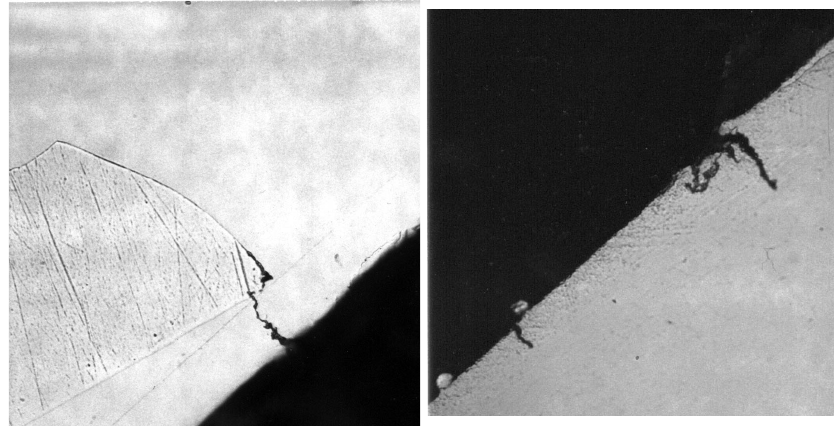
FIG. 17. An internal cross section of one end cap in the region of maximum temperature rise on the surface. The end cap surface is the boundary between the white and black regions of the pictures. The crack on the left propagated 25 (cid:3) m into the surface before reaching an internal grain boundary. The crack on the right propagated 15 (cid:3) m into the